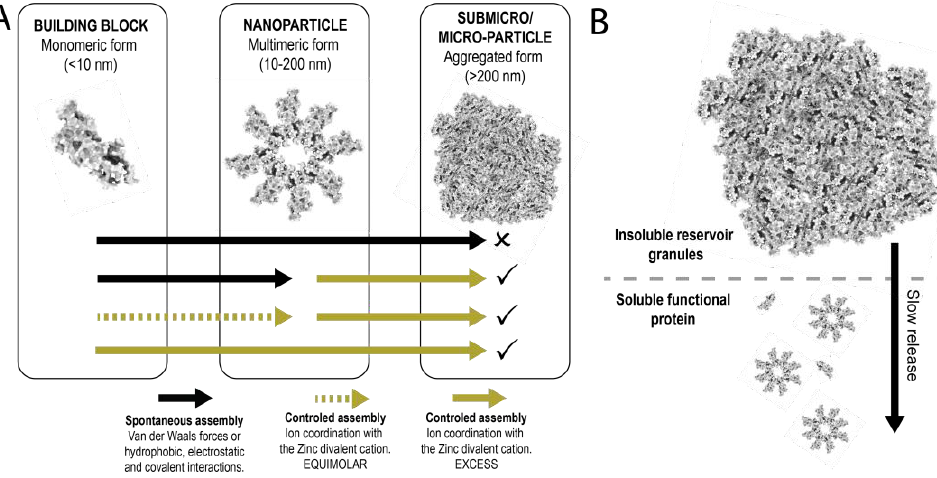
Figure 1. ( A ) In vitro formation of protein materials from monomeric (or protomeric) species. This occurs through oligomerization mediated by N-terminal cationic peptides plus C-terminal clustered histidine residues [35]. In most cases, assembly is spontaneous, as mediated by a set of cross-linking forces, such as those governing the formation of viral capsids. In others, the assembly must be assisted by the external addition of divalent cations [18]. A molar excess of divalent cations results in protein aggregation as microparticles with amyloidal architecture, which mimic secretory granules from the mammalian endocrine system [29]. ( B ) Under physiological conditions, these microparticles slowly disintegrate, releasing either monomers or nanoparticles [30,31]. Then, these materials act as depots for the slow in vivo administration of protein-based drugs. Upon subcutaneous administration [30], they mimic the behavior of functional, non-toxic amyloids, regarding the sustained release of the building block polypeptides [36–41].